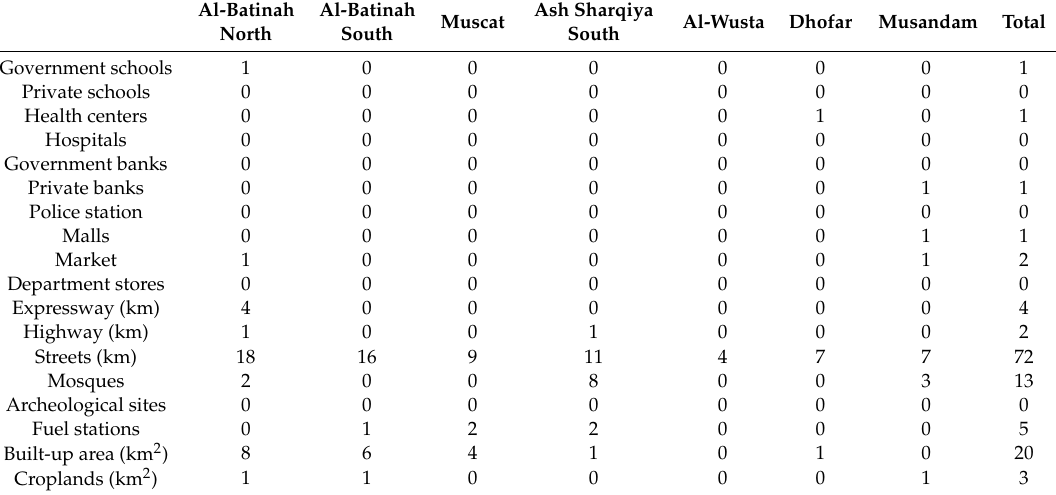
Table 5. The vulnerability matrix of the 5 m tsunami scenario at the governorate